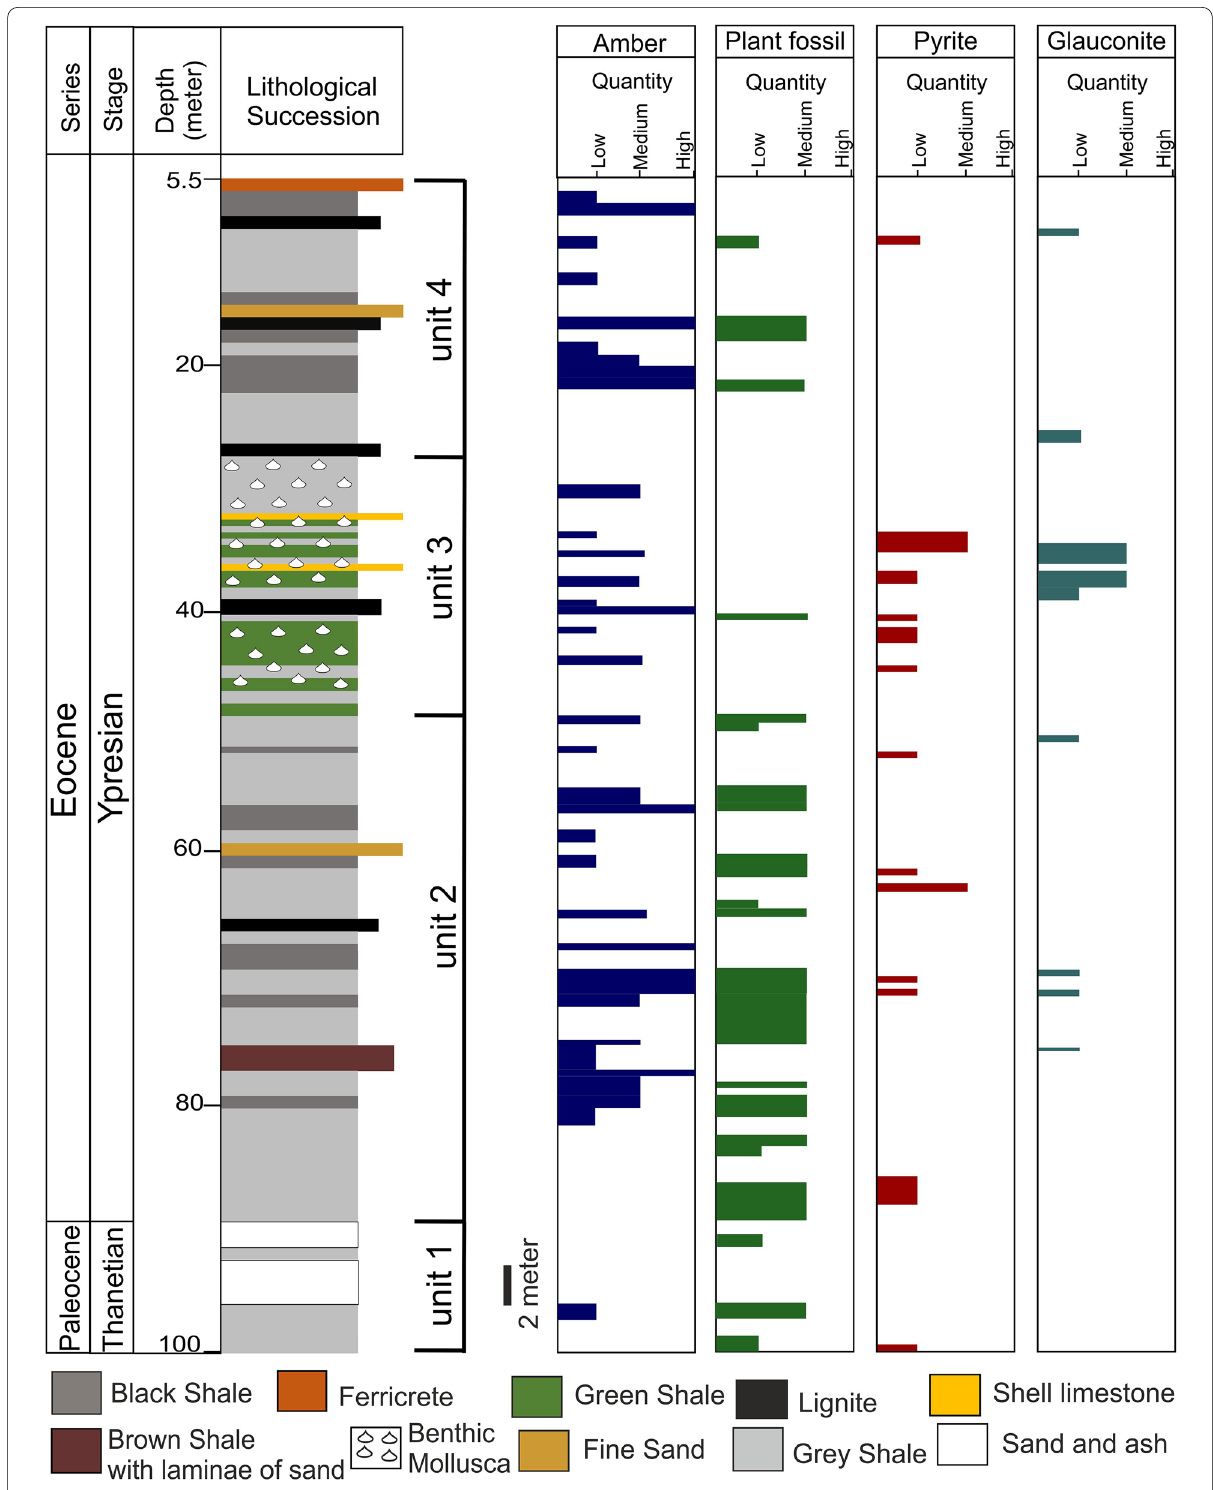
Fig. 2 Lithostratigraphic section of the Umarsar mine as revealed from the 103 no. drill-core. The four informal units of the succession are marked. Relative quantities of amber, plant matter, pyrite and glauconite in different levels are